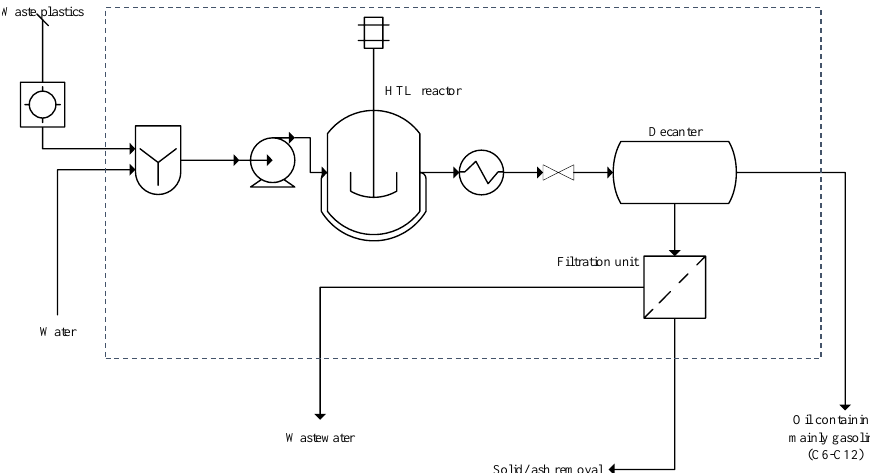
Figure 2. Waste plastic conversion to the liquid fuel of hydrocarbons (control volume indicated with dashed lines).